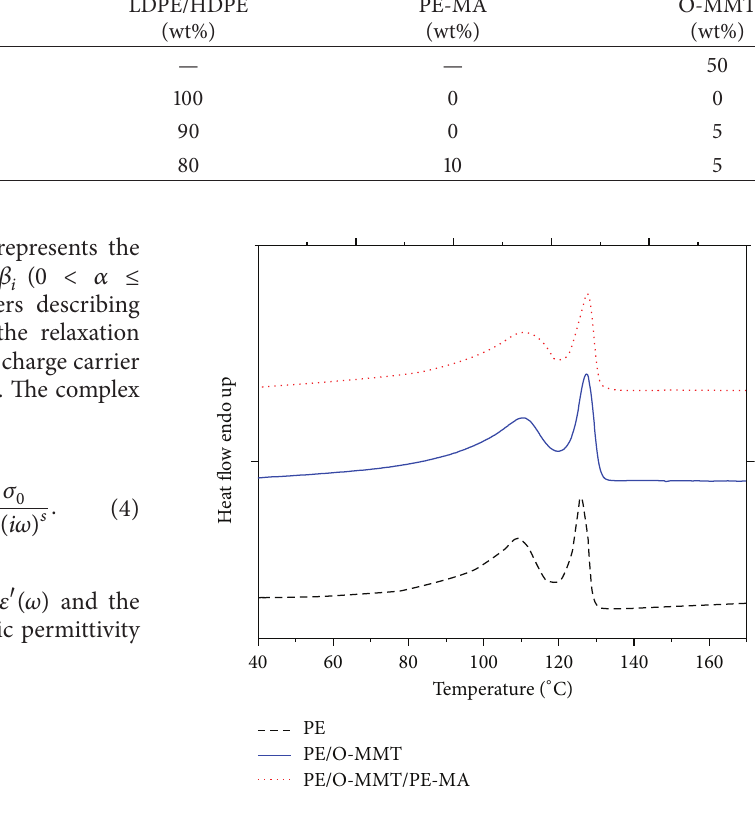
Figure 1: DSC heating thermograms of neat PE, PE/O-MMT, and PE/O-MMT/PE-MA